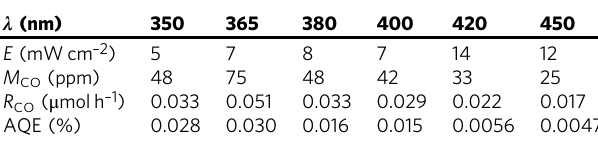
Table 1 The measured E , M CO , and the calculated R CO , AQE at different monochromatic wavelengths over the 2% Mn, C-ZnO